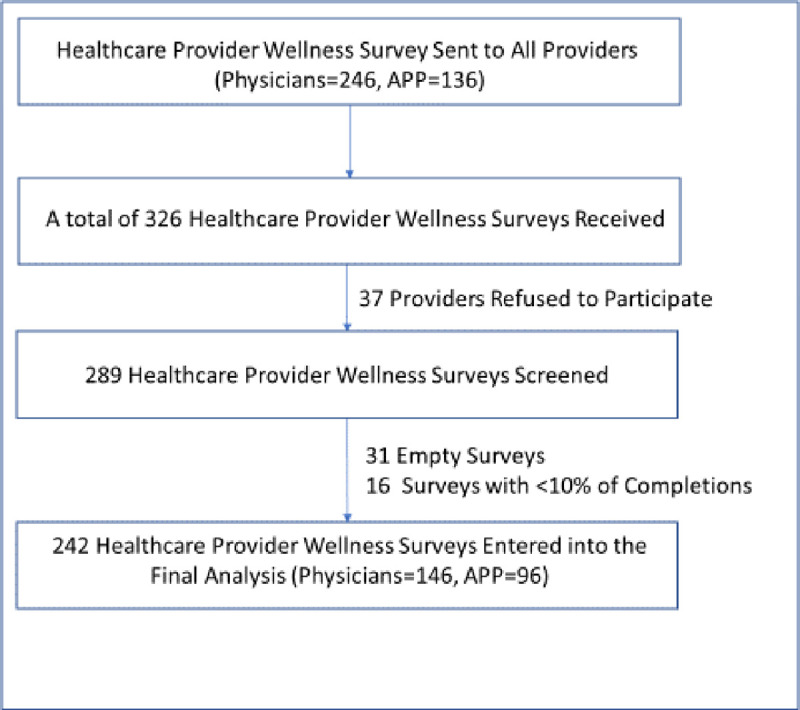
Study flow diagram.